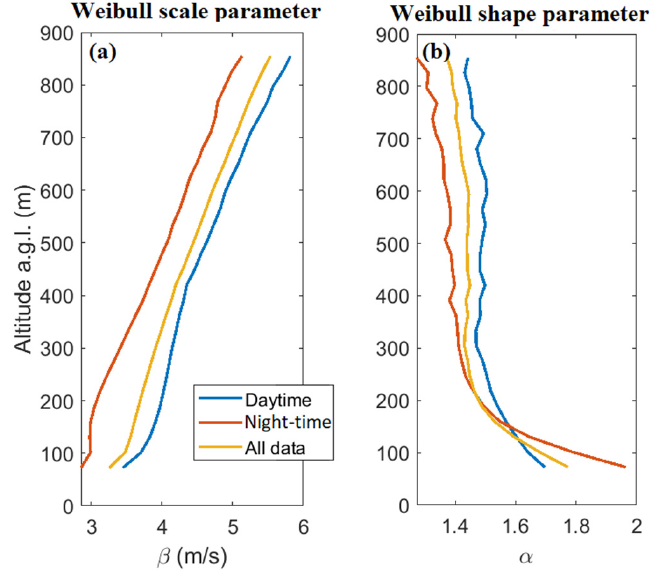
Figure 4. Weibull parameter profiles calculated for all data (yellow), only daytime data (blue) and only night-time data (orange): ( a ) scale parameter; ( b ) shape parameter.